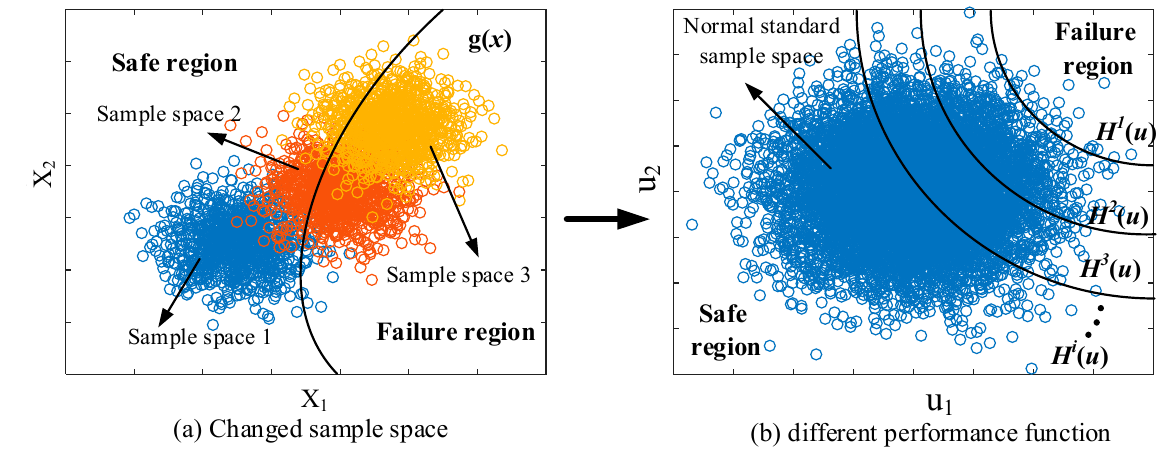
Figure 8. Transformation from the degenerate sample space to the standard normal space.